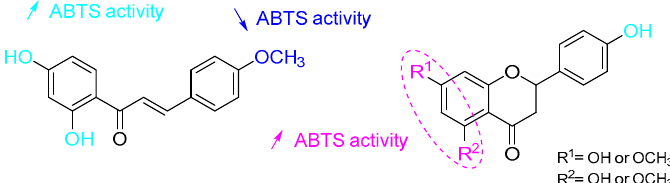
Figure 3. Structure/activity relationships established for ABTS scavenging activity.